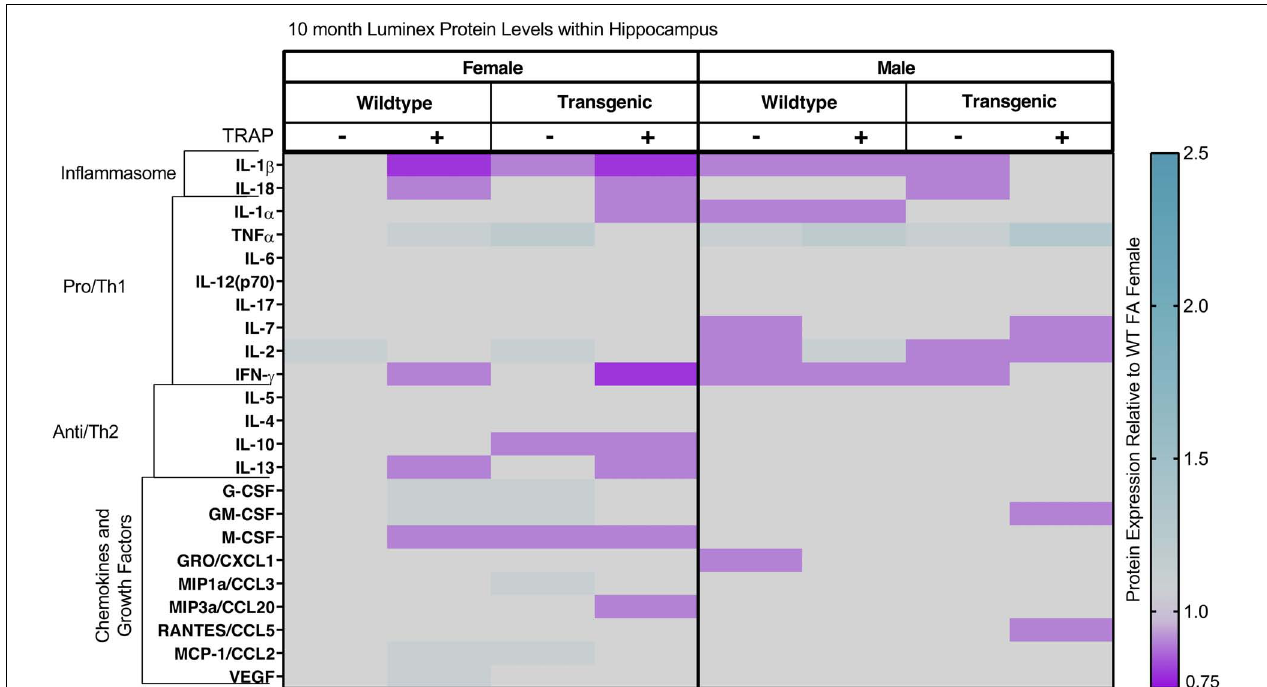
FIGURE 8 | Heat map representation of hippocampal cytokine, chemokine, and growth factor changes in response to TRAP in 10-month old TgF344-AD and WT rats. Hippocampal levels of cytokines and growth factors in TgF344-AD and WT rats exposed to FA or TRAP for 9 months were analyzed using multiplex technology. For each analyte, individual values were normalized to the mean level of that same analyte in hippocampal tissue from female FA WT animals. Purple indicates normalized protein levels < 1.0; turquoise indicates normalized protein levels > 1.0. ± indicates exposure with + identifying TRAP-exposed animals; - indicating FA-exposed animals; n = 4–5 animals per group (duplicate samples were analyzed for each animal). Non-normalized cytokine values for female WT animals are provided in Supplementary Table 2